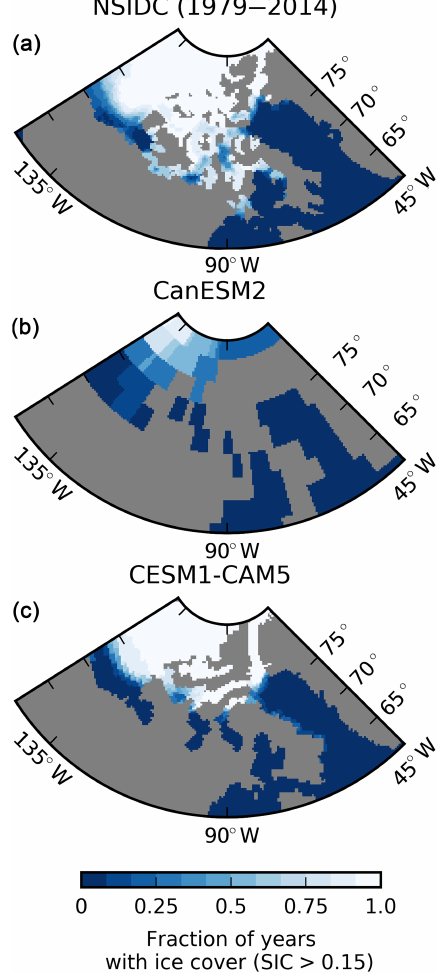
Figure 8. (a) Fraction of years (1979–2014) with September sea ice cover (sea ice concentration > 0.15) for the NSIDC passive mi- crowave product on an EASE 25km grid. (b) as in (a) but for the CanESM2 model, remapped using a nearest-neighbour remapping. (c) as in (b) but for the CESM1-CAM5 model. The grey shading indicates the land–sea mask for each dataset. The NCAR CESM1 CICE grid provide a rough indication of how geographical features of the Canadian Arctic, such as the Canadian Arctic Archipelago, might be resolved in future configurations of CanESM2. Also evi- dent is the low September sea ice extent bias in